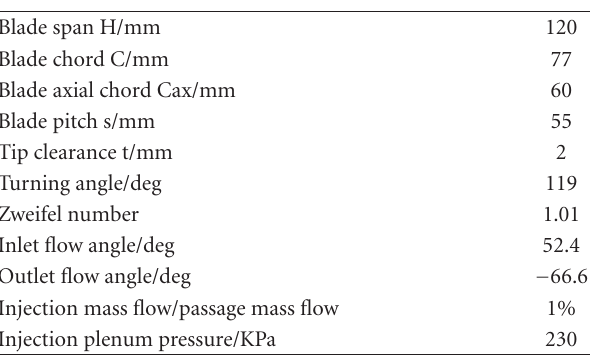
Table 1: Cascade geometric